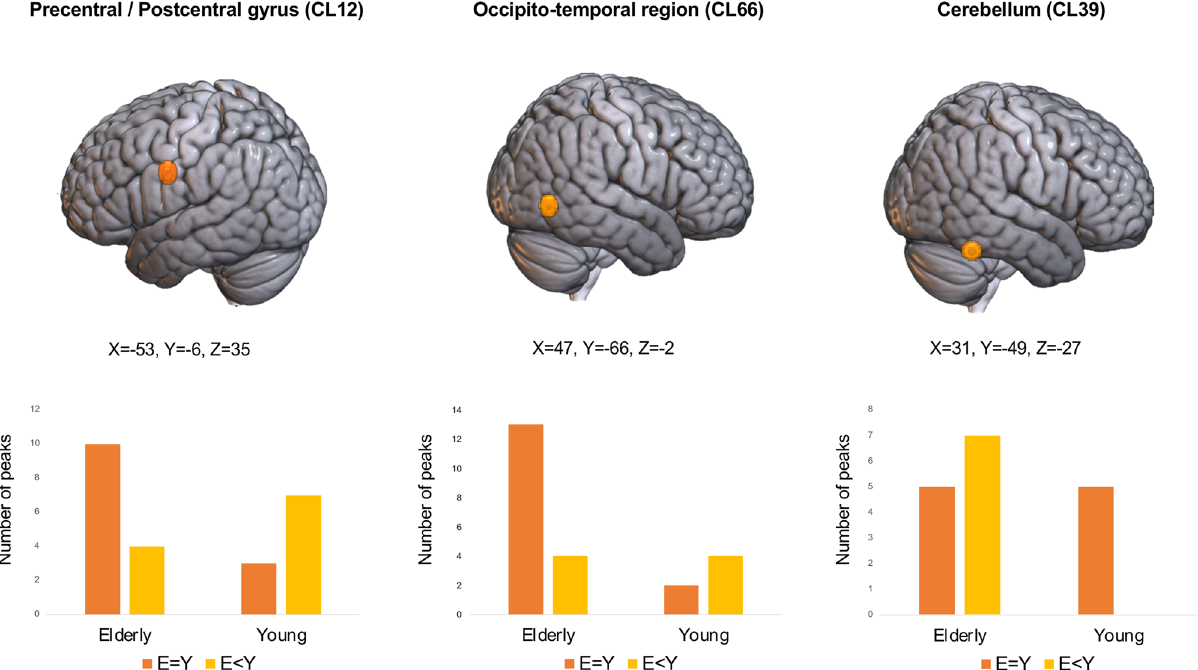
Fig. 2 Clusters showing a signi fi cant group-by-performance interaction effect. Top: Distribution of clusters showing a signi fi cant group-by-performance interaction effect. Bottom: Bar plot for the signi fi cant group-by-performance interaction, from left to right, in the left precentral/postcentral gyrus, in the right occipito-temporal cortex and in the right cerebellum. Orange bars indicate the number of peaks of each cluster associated with an equal performance between the elderly and the young group, yellow bars indicate the number of peaks of each cluster associated with a declined performance of the elderly group. Plots source data are provided in Supplementary Data